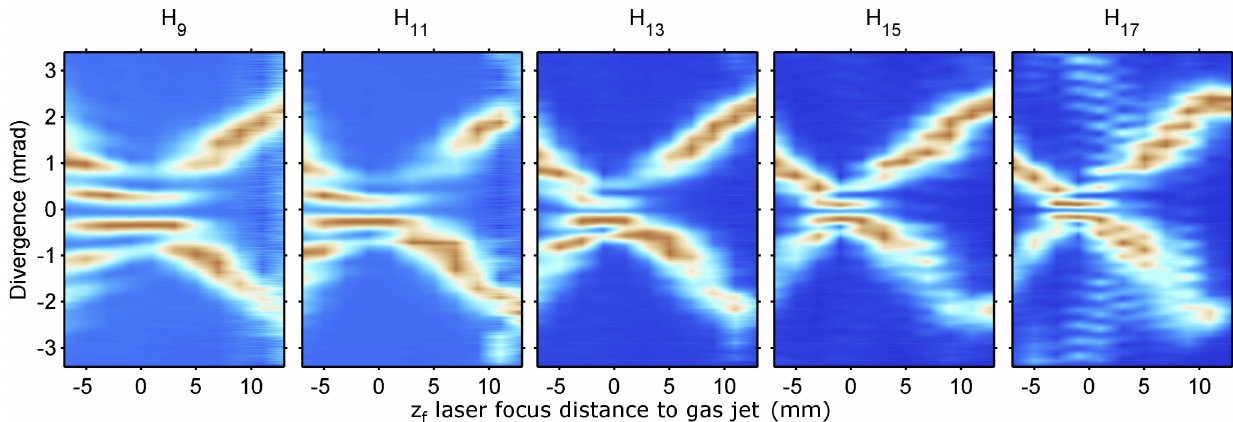
(Color on-line) Far-field profile of H CELIAgenerated with a 0- π phase-plate when the gas jet is moved through the focus. The peak intensity has been normalized for each harmonic and each position of the gas jet. The gas target is